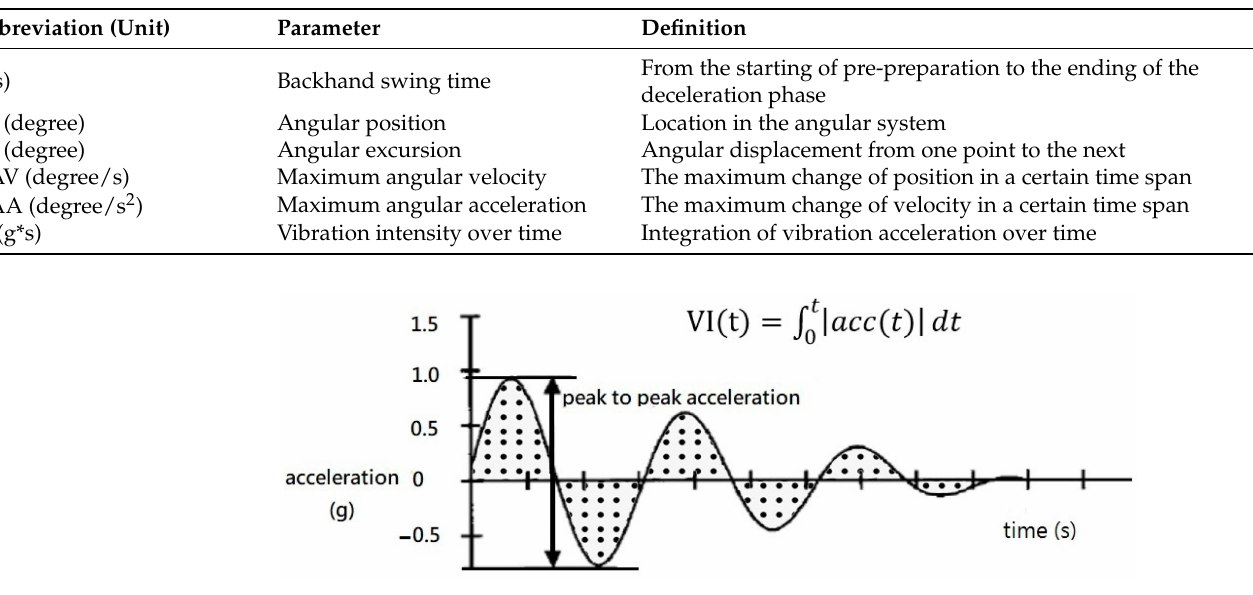
Figure 1. Integration of vibration Intensity over time